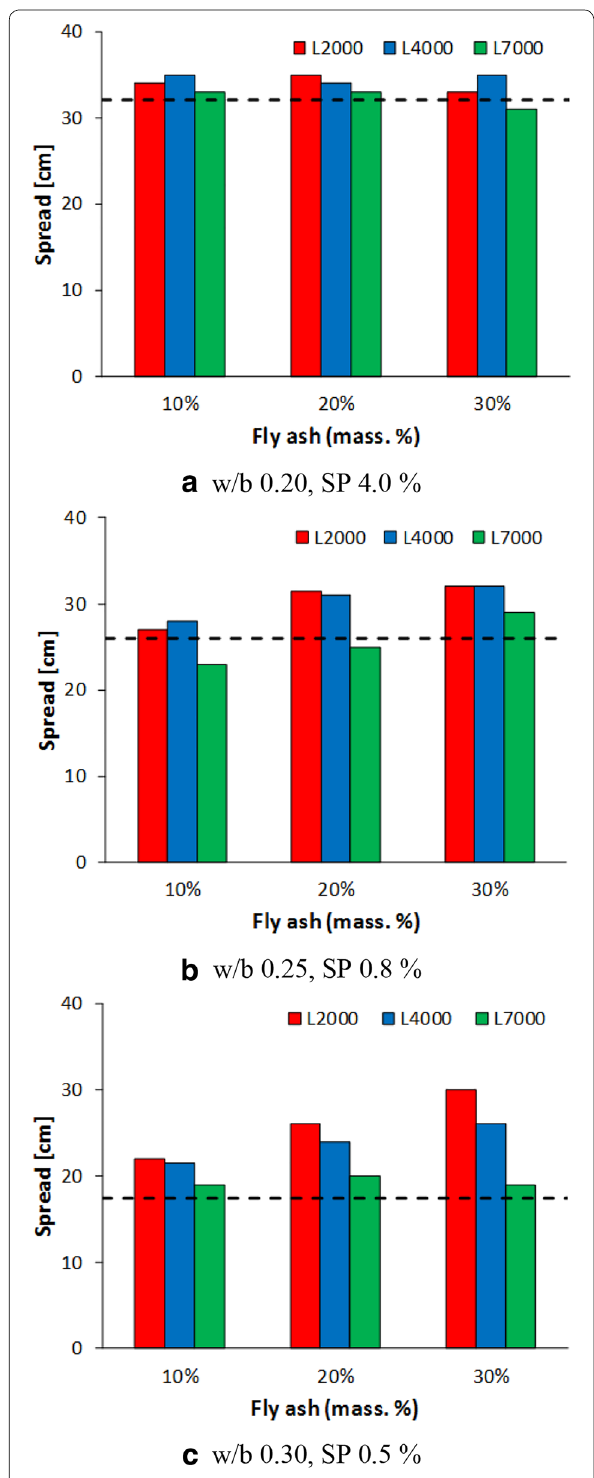
Fig. 4 Influence of replacement ratio of WLP on spreading distance depending on different fineness of the WLP. The dashed line in each figure indicates the spreading of a controlled cement paste not incorporating